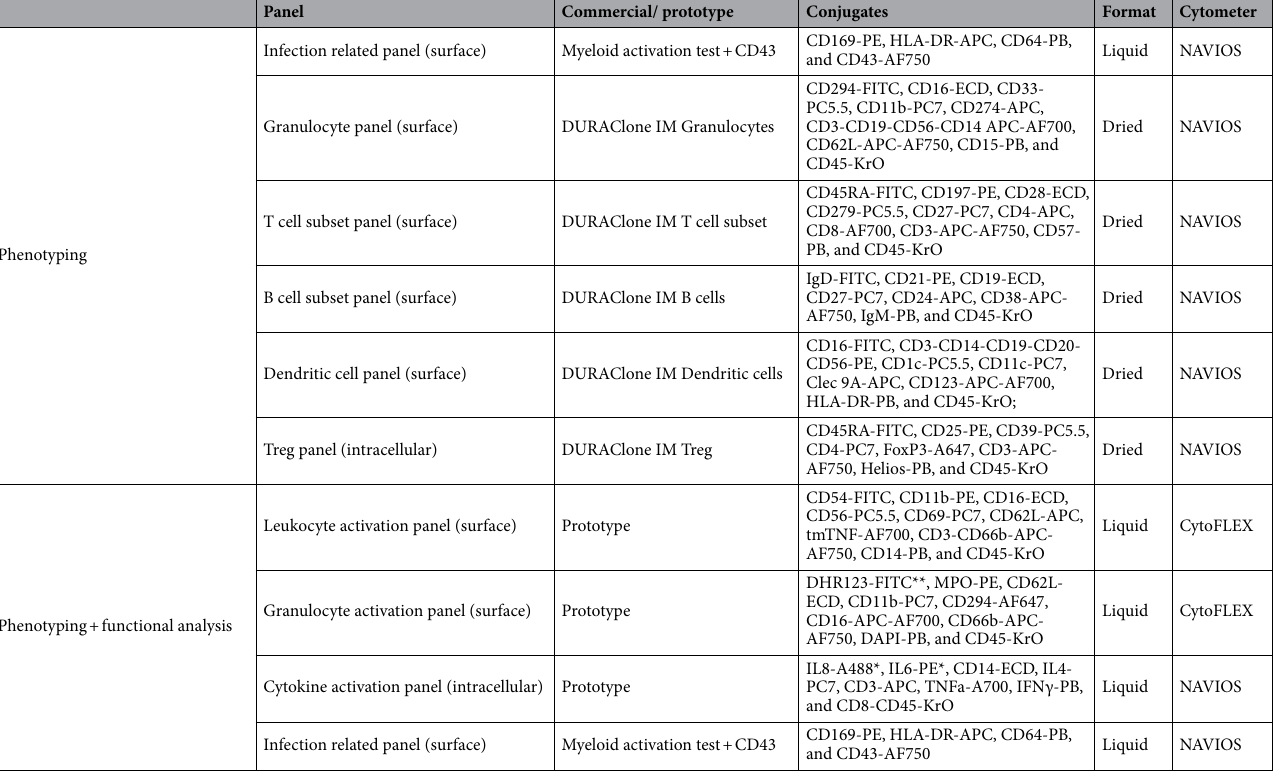
Table 1. Flow cytometry panels used in the study. All the products are from Beckman Coulter except those indicated: *Product from Biolegend (San Diego, USA), **Product from Invitrogen (Waltham,